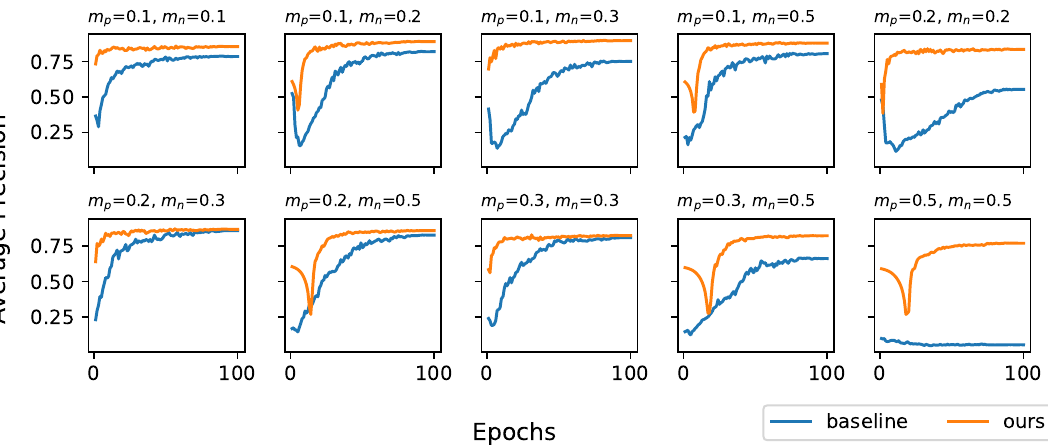
Figure 4. Grid search on distance margins. m p is the distance margin for positive motion pairs, or the maximum tolerated distance between representation vectors of the same motions. m n denotes the margin for negative pairs, the minimum distance between two vectors representing different motions without loss penalty. Blue curves denote the baseline model, and orange curves represent our new model. The Y-axis is shared among all